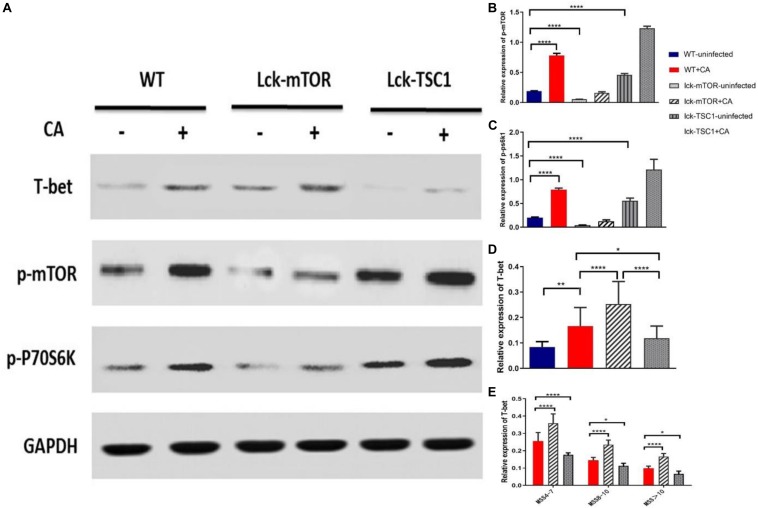
Expression of T-bet in different degrees of Candida sepsis is regulated by mTOR. (A–E) Protein levels of T-bet, phospho (p)-mTOR and p-P70S6 were quantified by western blotting from sorted CD4+ T cells in wild-type (WT), mTOR knockout (Lck-mTOR) and TSC1 knockout (Lck-TSC1) mice. The amount of each protein level was normalized by GAPDH. Mean ± SD, 10 mice per MSS group (“+CA” groups contained all infected mice of three MSS groups), analyzed by one-way analysis of variance multiple comparisons. *P < 0.05, **P < 0.01, ****P < 0.0001.